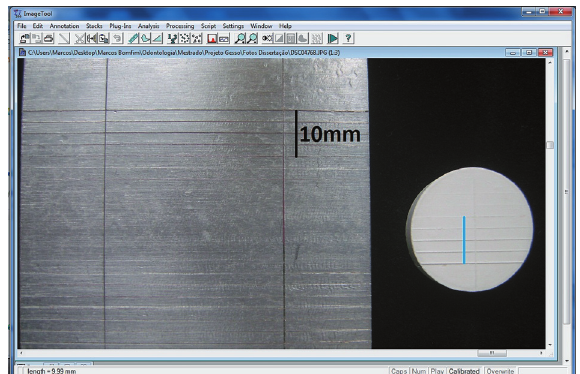
Figure 1- Sample used for software analysis of dimensional change. Black line indicates calibrated scale and blue line the measurement of the sample